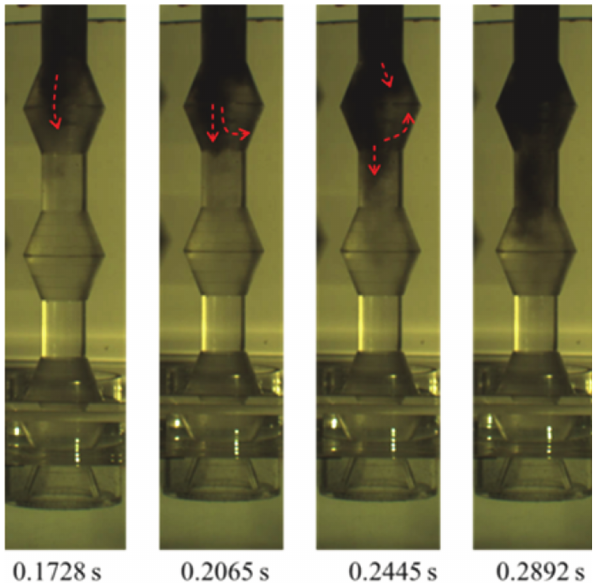
Figure 6: Ink dispersion in the first chamber filmed by a high-speed